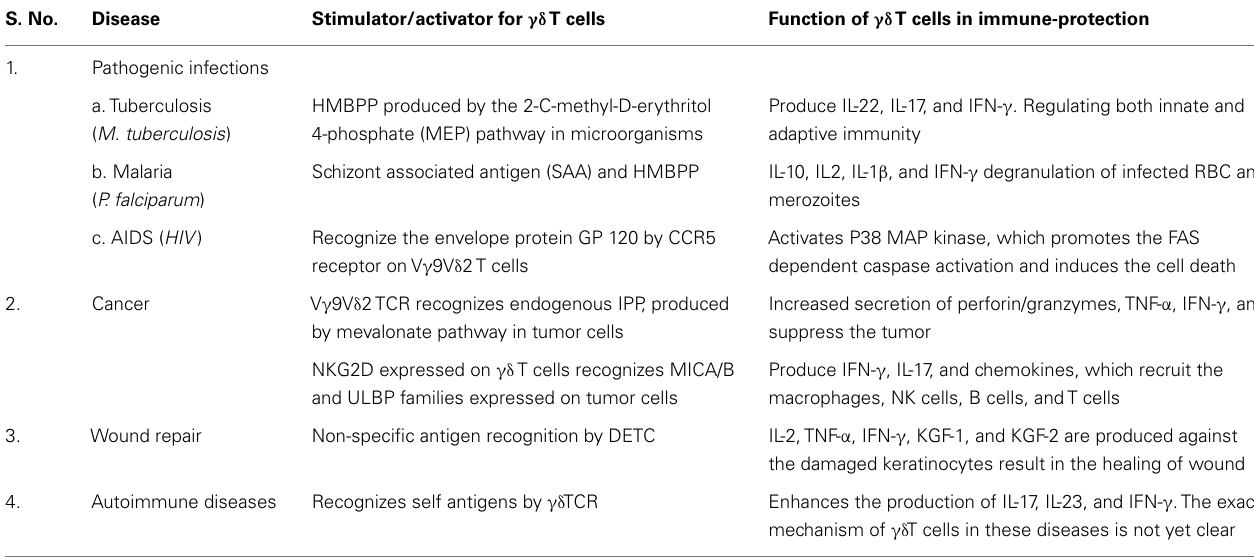
Table 1 |Antigen recognition and functions of γδ T cells in various diseases . γδ T cells recognizes various antigenic factors and produce respective chemokines and cytokines to protect immune system against from different diseases like pathogenic infections, cancer, wound repair, and autoimmune. S.